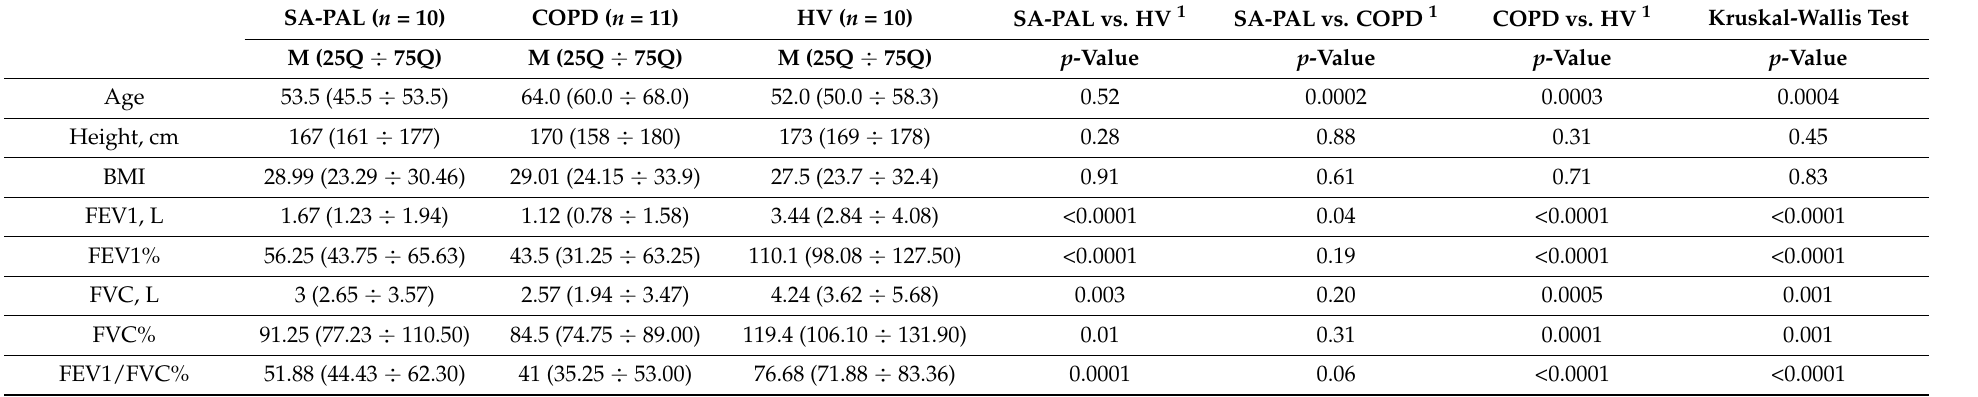
Table 1. Patients’